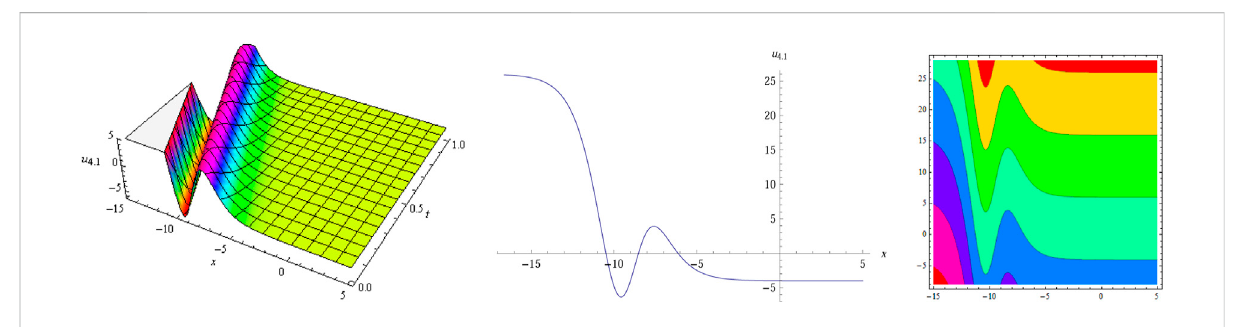
FIGURE 10 3D plot, 2D plot, and contour plot of u 4 . 1 with α (cid:2) β (cid:2)